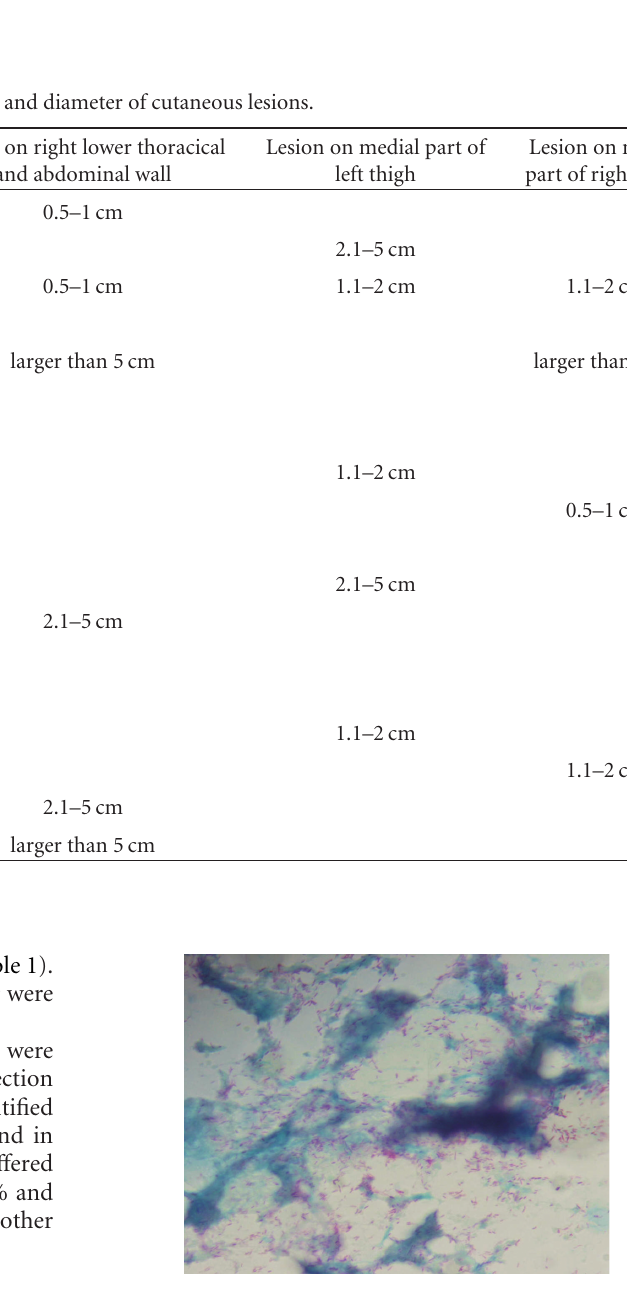
Figure 1: Acid fast organisms stain in bright pink